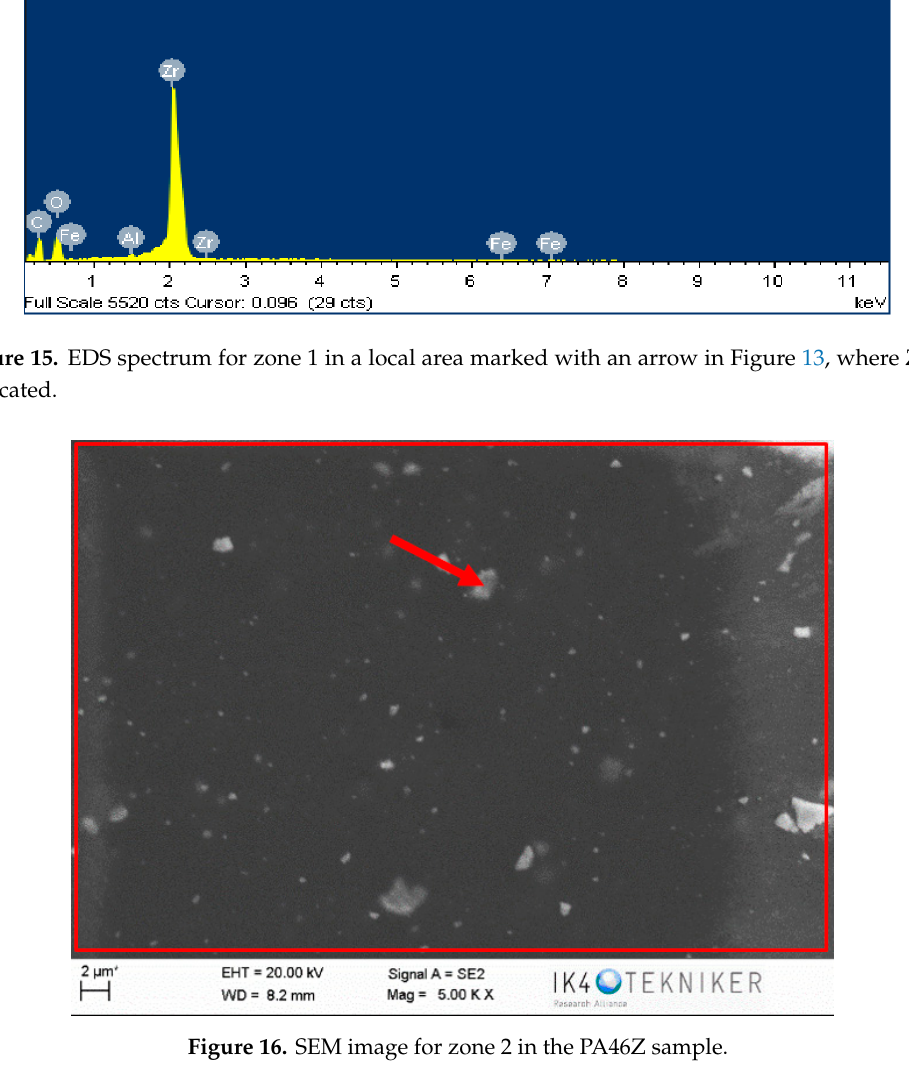
Figure 16. SEM image for zone 2 in the PA46Z sample.